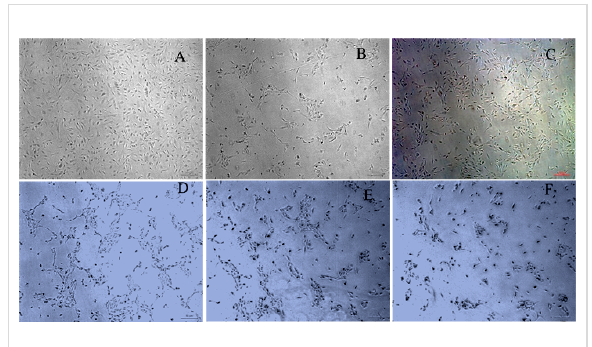
Figure 13: Morphology of HUVECs cultured in serum-free medium after (A) 0 h, (B) 24 h, and (C) 48 h; (D) control (E, F) HUVECs after 4 h of treatment with PVI–siRNA complex (100 nM).